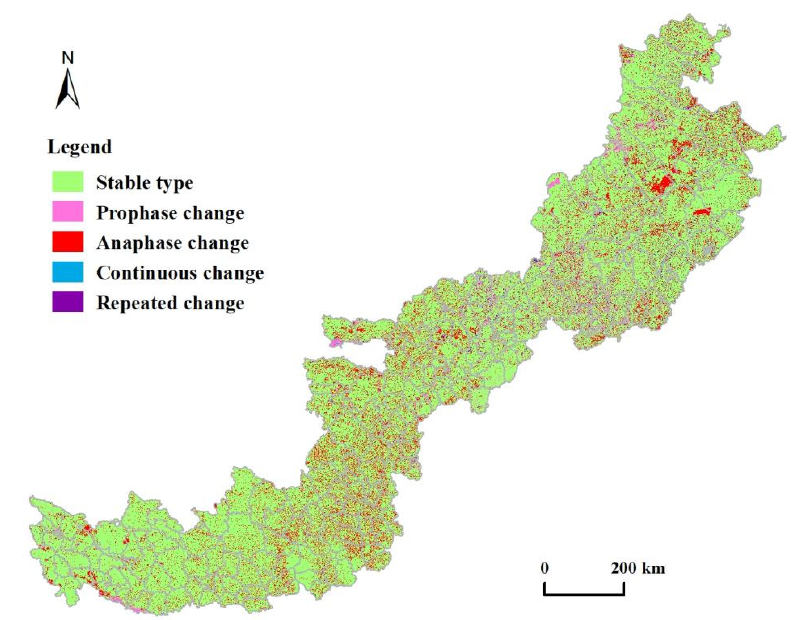
Figure 4. Geo-information of land-use structure change in the AENC during 2000–2020.